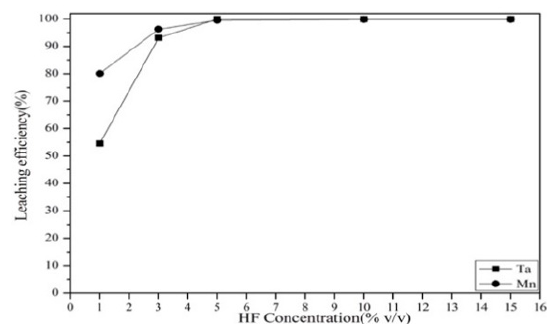
Figure 5. Effect of hydrofluoric acid concentration on the leaching efficiency. Temperature: 220 °C (23 atm). Liquid–solid ratio: 100 mL per gram. Reaction time: 3 h.